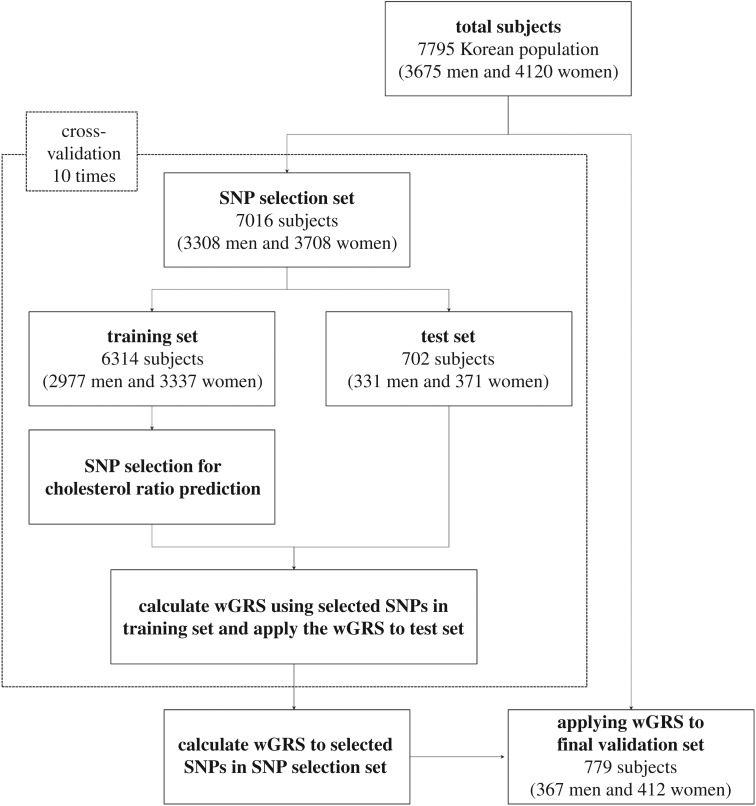
Analysis flow chart for prediction of cholesterol ratios.